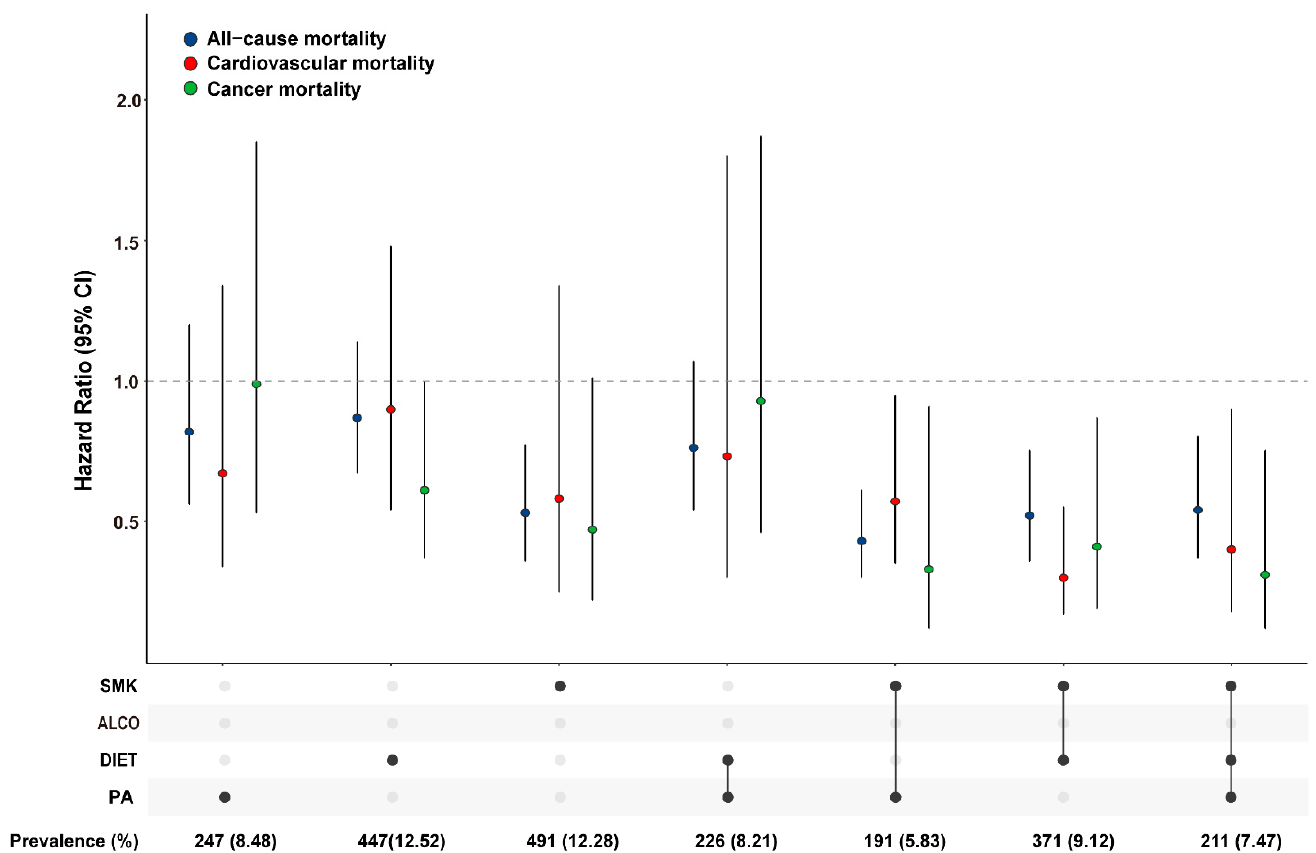
Figure 2. Association between combinations of the healthy lifestyle factors and risk of mortality in NAFLD patients.